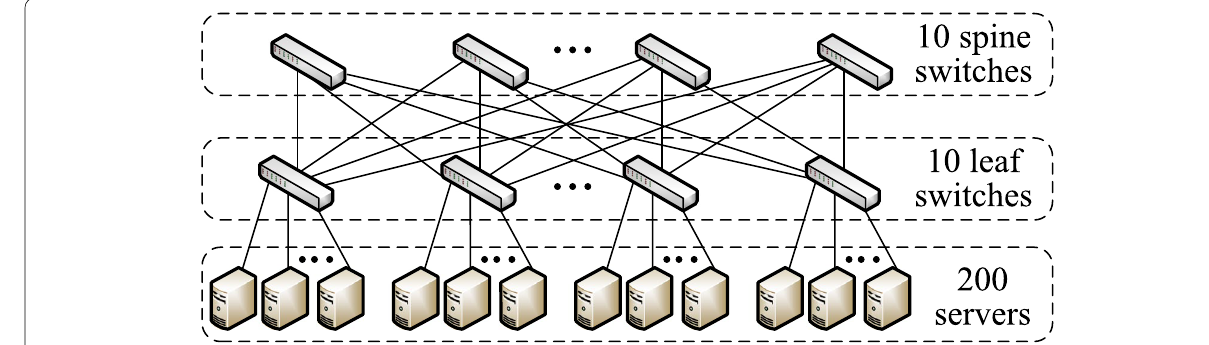
Fig. 11 Leaf-Spine topology